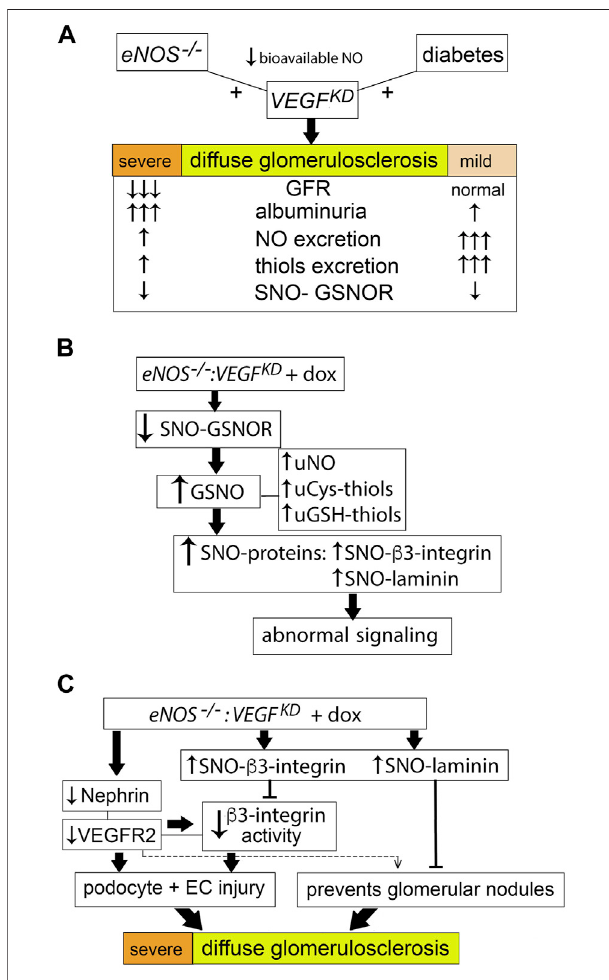
FIGURE 8 | Proposed model of podocyte VEGF KD driven diffuse glomerulosclerosis in DM- VEGF KD and eNOS:VEGF KD mice. (A) Strong compensatory NO and thiol generation prevents GFR loss, attenuates proteinuria and diffuse glomerulosclerosis in diabetic VEGF KD mice, while limitation of this compensatory mechanism in eNOS:VEGF KD mice worsens the renal phenotype, leading to renal failure. (B) Reduced GSNOR S-nitrosylation increases GSNO and promotes increased S-nitrosylation of proteins, altering their signaling pathways: (C) decreased nephrin and VEGFR2 signaling and high SNO- β 3-integrin inhibit β 3-integrin activity leading to podocyte and endothelial cell injury; high SNO-laminin and low VEGFR2 signaling may contribute to the severe diffuse glomerulosclerosis described herein in eNOS:VEGF KD + dox mice.